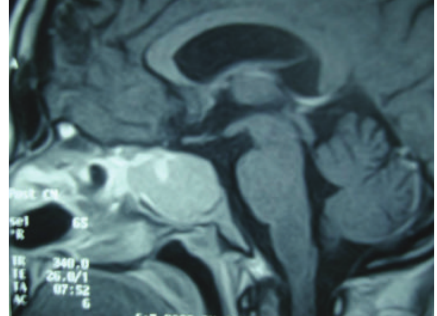
Figure 1: MRI sagittal view (T1-weighted with IV contrast) showing an enhanced sellar and suprasellar mass 2.2 × 2.2 × 2.4 cm (approxi- mately 2.5 years before developing pituitary apoplexy in November